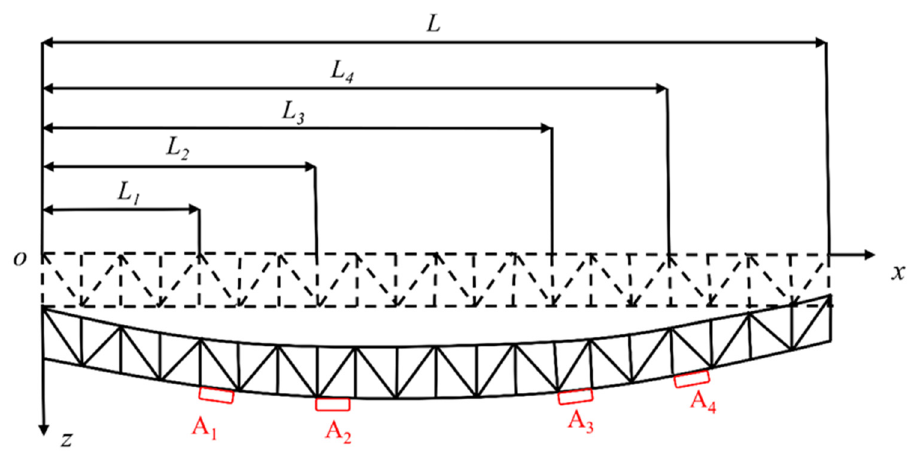
Figure 5. Layout scheme for deflection monitoring.